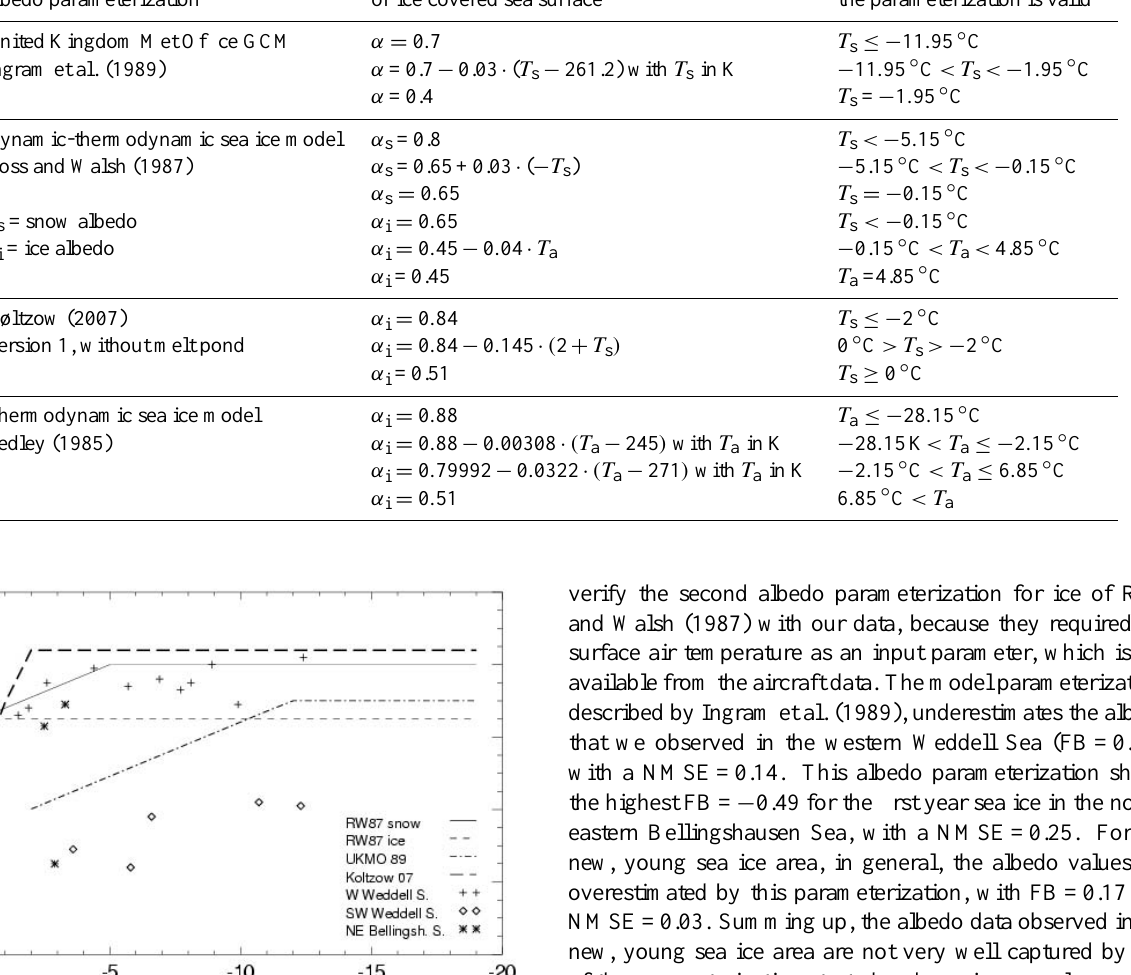
Table 3. Model temperature albedo parameterizations with T s =surface temperature and T a =air temperature. Reference (or origin) of Albedo parameterization schemes for sea ice Temperature range for which albedo parameterization or ice covered sea surface the parameterization is valid